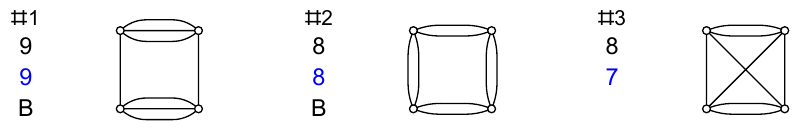
Figure 4 . All vacuum diagrams of order g 4 . The upper integer, shown in black, gives the leading power of N in the model of a symmetric traceless rank-3 tensor of O ( N ); the lower integer, shown in blue, gives the leading power in the model of a tri-fundamental of O ( N ) 3 . The letter B labels the bi-partite diagrams.